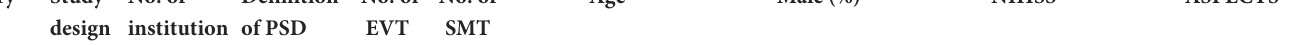
TABLE 1 Characteristics of the studies included in the